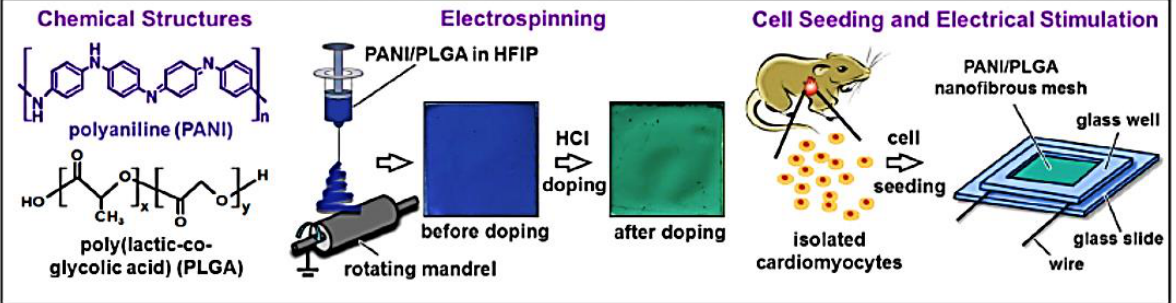
Figure 5. Graphic for the fabrication of aligned conductive polyaniline (PANI)- and poly(lactic-co- glycolic acid) (PLGA)-based nanomaterials for drug delivery [104]. Reproduced with permission from Elsevier.